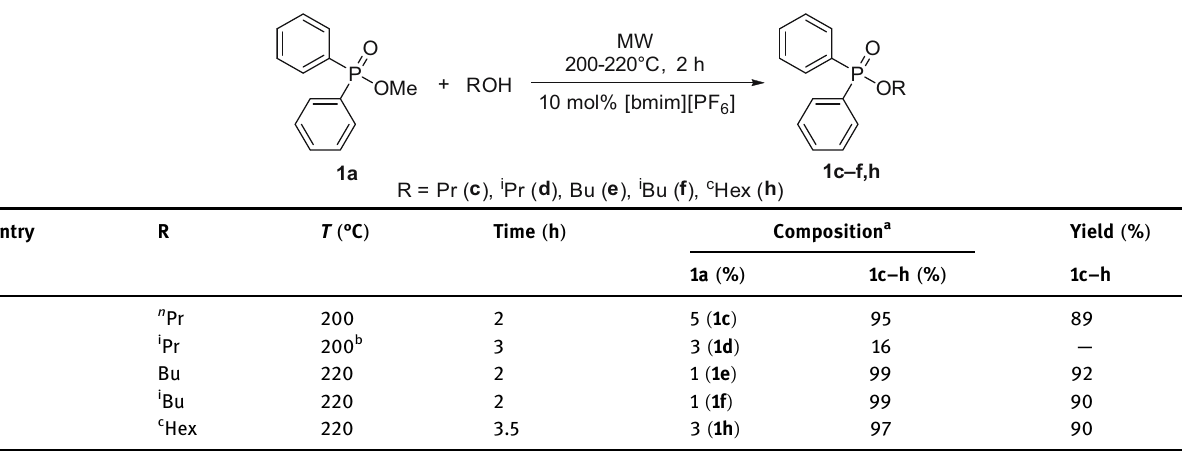
Table 6: Alcoholysis of methyl diphenylphosphinate with di ff erent alcohols under MW conditions in the presence of 10 mol% of [ bmim ][ PF 6